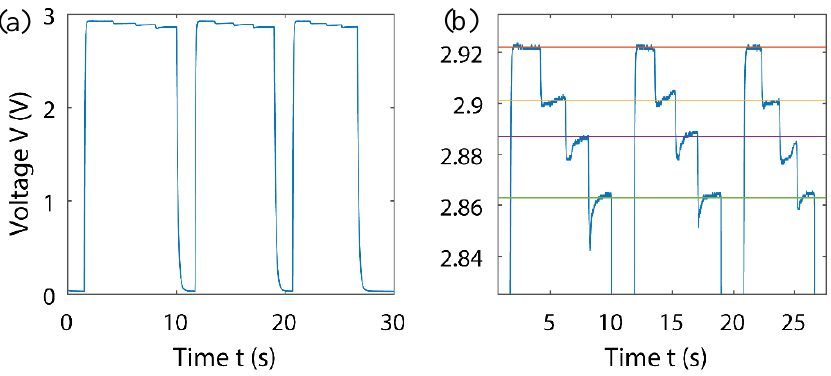
Figure 11. ( a ) Contact of sensor to ball, ( b ) close-up showing four distinct levels of applied force.